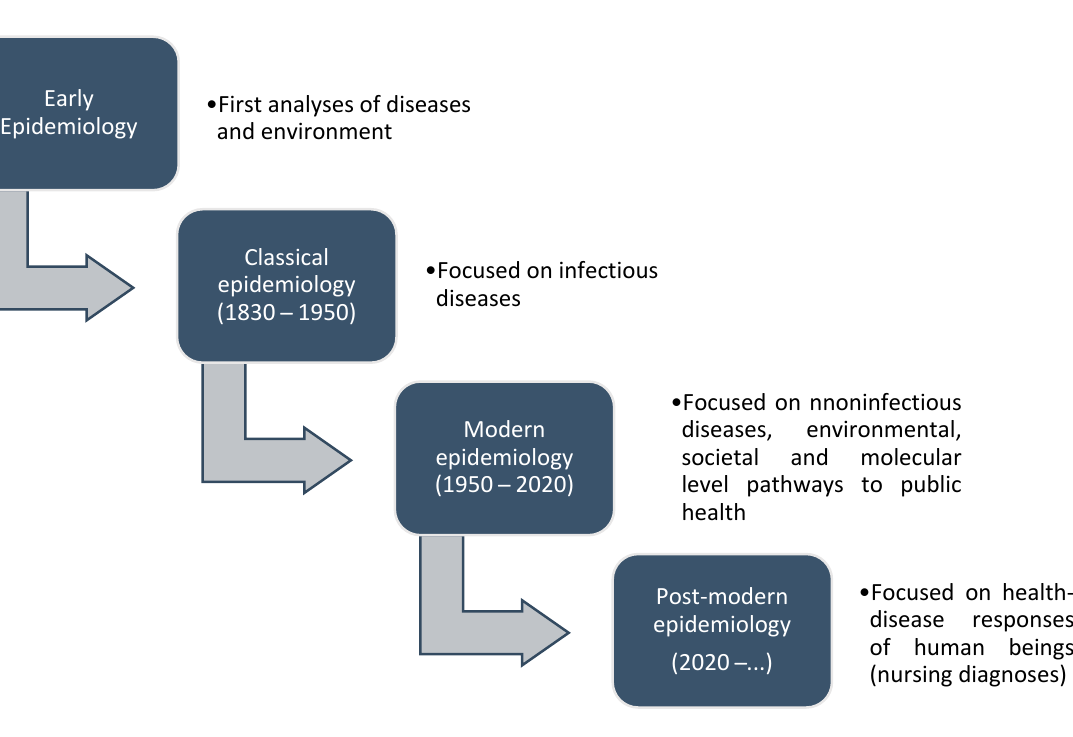
Figure 1. Development of epidemiology (adapted from Melo (2020) [5]).